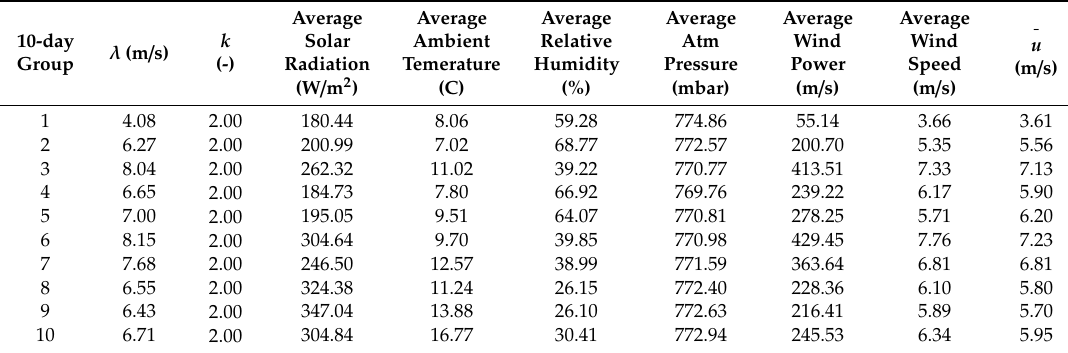
Table 4. Characteristic parameters for group periods of 10 days each during the WS season.